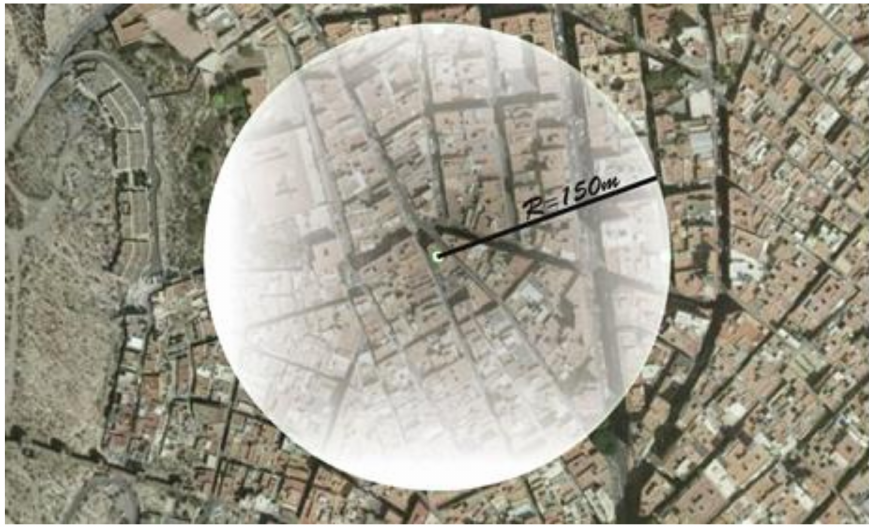
Figure 5. Aerial view of the control area in Almer í a. Source: Own